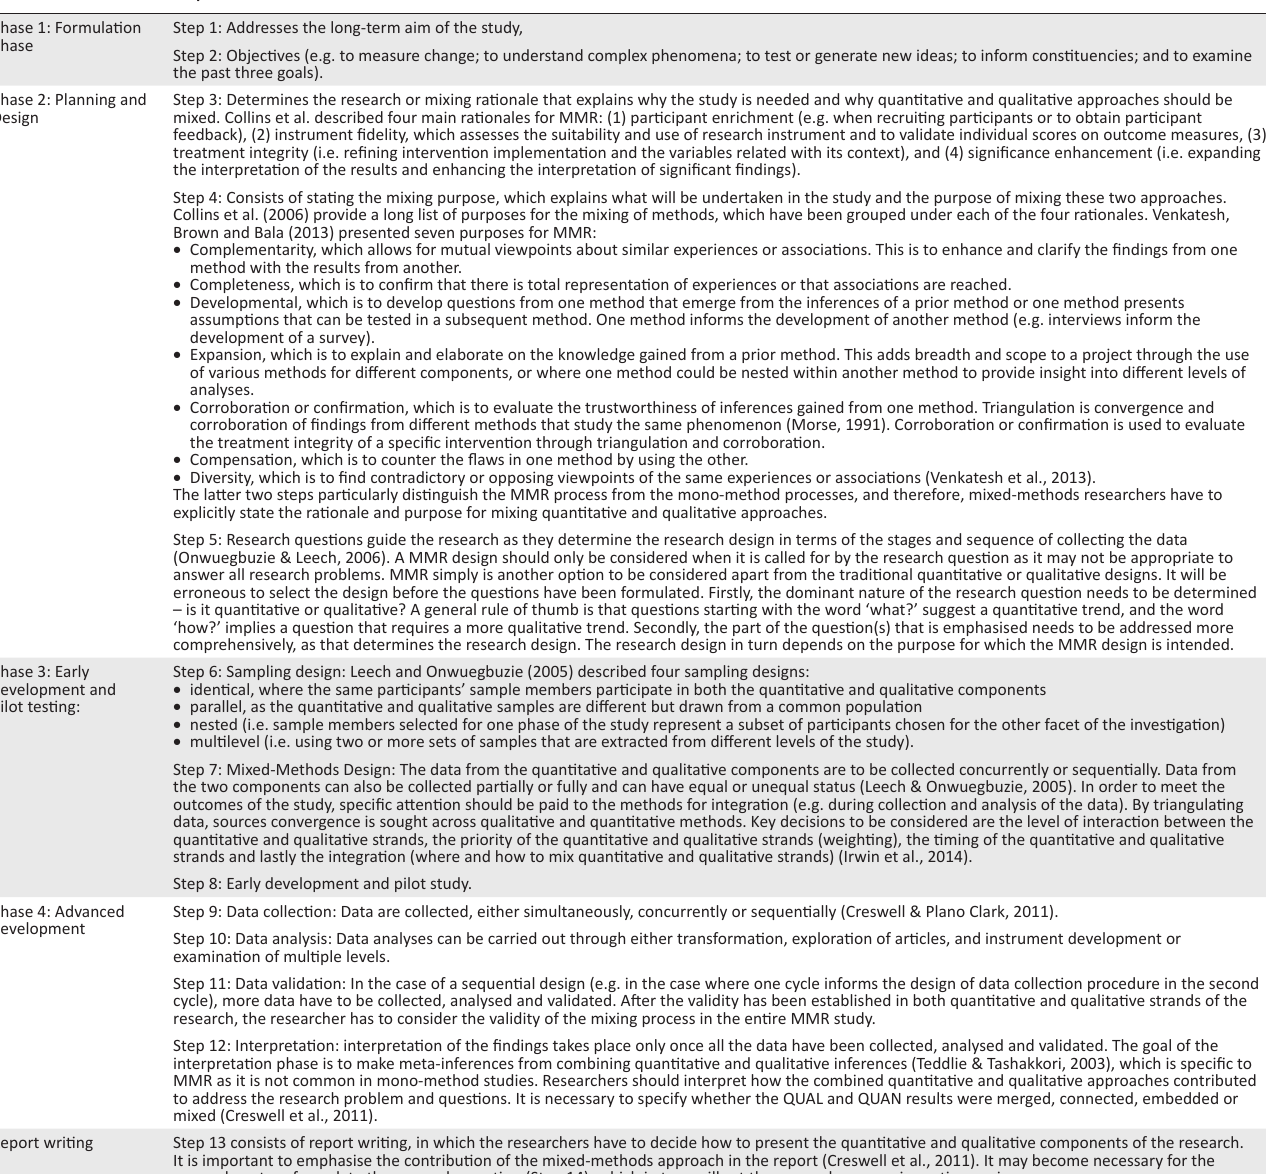
TABLE 2: The mixed-methods research